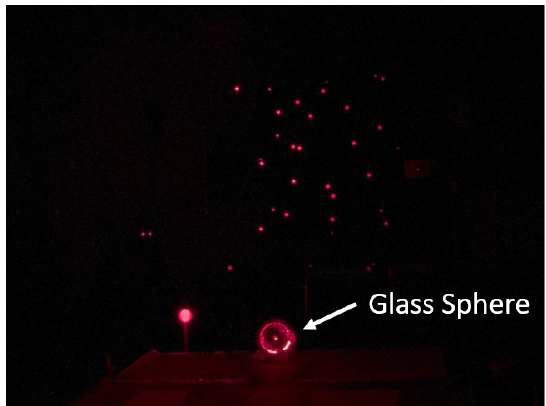
Figure 5. Subsection of a camera image showing the glass sphere captured through a conventional camera lens with illumination provided by a ring light, unlike image 4 the glass sphere can clearly be seen with little backscatter or noise present. Spherical retro reflective photogrammetry targets can also be seen in this